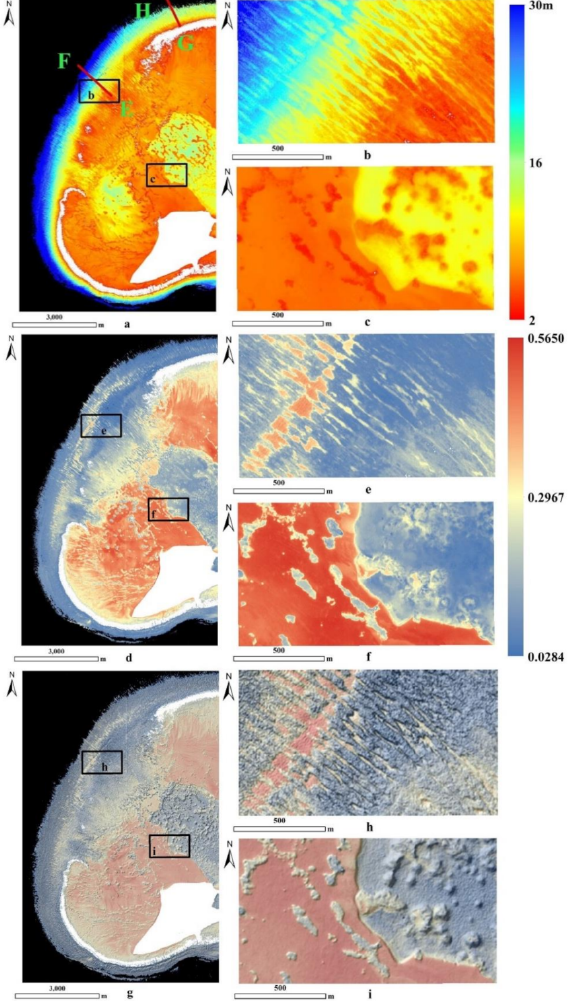
Figure 8. Inversion results of Midway Island using WorldView-2. ( a ) Bathymetry map, where ( b , c ) are partial magnification maps of ( a ), EF , GH were used to assess inversion ranges under different bottom reflectance in Section 4.4. ( d ) Bottom reflectance map at 550 nm, where ( e , f ) are partial magnification maps of ( d ). ( g ) Superimposed map of ( a , d ), where ( h , i ) are superimposed maps of ( g